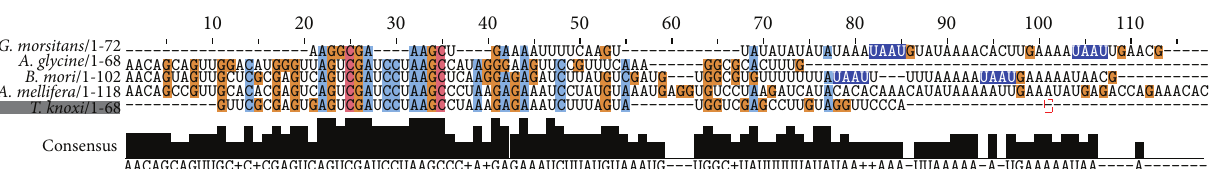
Figure2:Multiplealignmentofgapregionof B.mori 28SrRNAsequenceagainstcorrespondingregionin G.morsitansmorsitans , A.mellifera , A. glycine , and T. knoxi . Dots indicate gaps introduced during alignment to maximize homology. UAAU highlighted in blue forms the “hidden break” in rRNA sequences from different organisms.